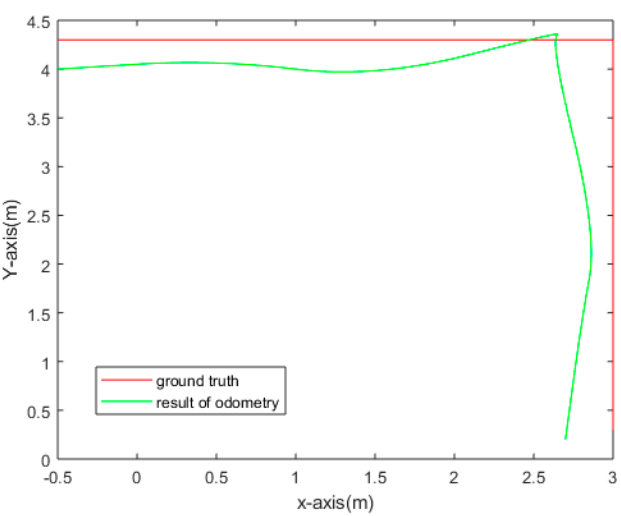
Figure 14. The rectification result of image pairs in Figure 13.